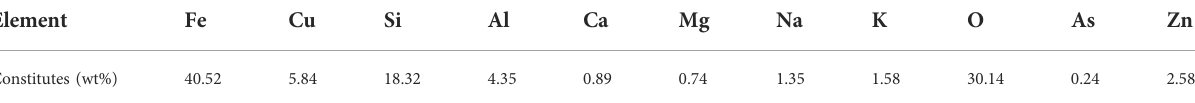
TABLE 1 Chemical constitution of CS (X-ray fl uorescence data). Element Constitutes